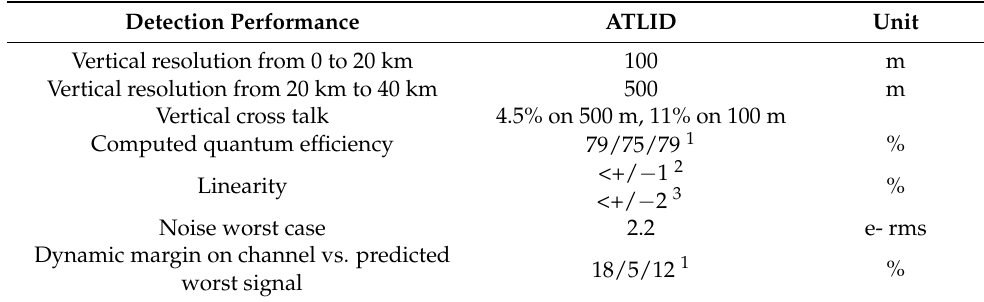
Table 2. ATLID detection performance.